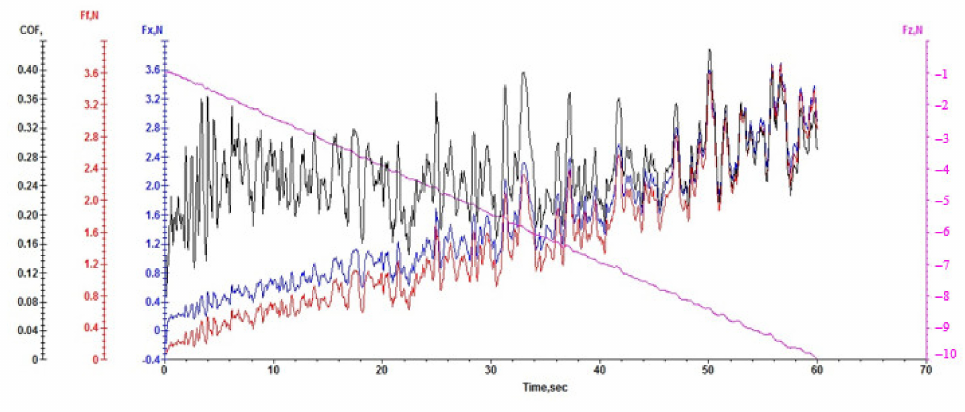
Figure 14. Scratch test for phosphate nodular cast